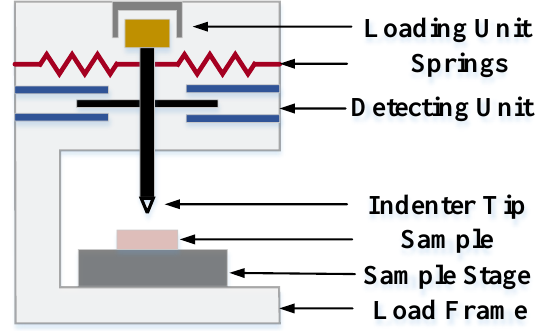
Figure 3. Schematic diagram of a nanoindenter instrument.